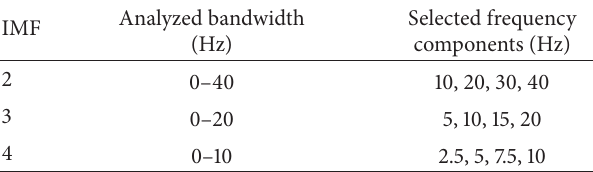
Table 1: Selected frequency components for each